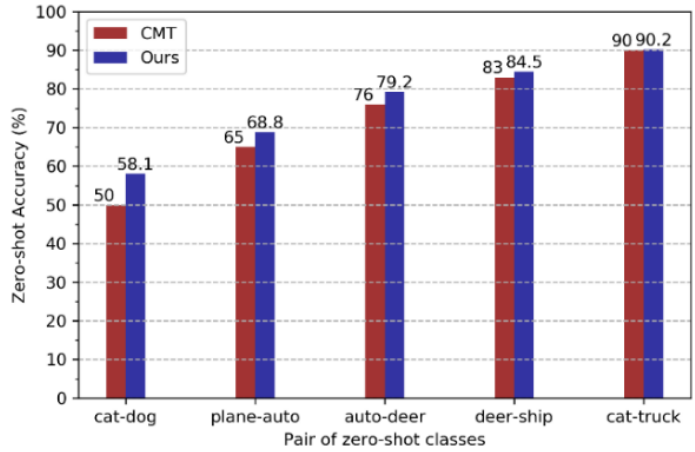
Figure6. Hit@1zero-shotcross-modalretrievalperformanceforfivezero-shotcategorysetsinCIFAR-10. Figure 6. Hit@1 zero-shot cross-modal retrieval performance for five zero-shot category sets in CIFAR-10.